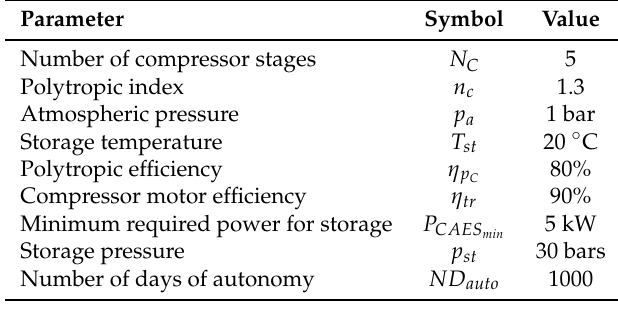
Table 8. WDCAS model input parameters.